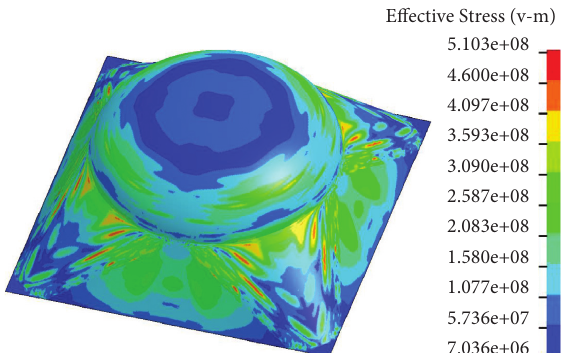
Figure 16: The maximum von Mises stress contour of the EBD at 1atm.